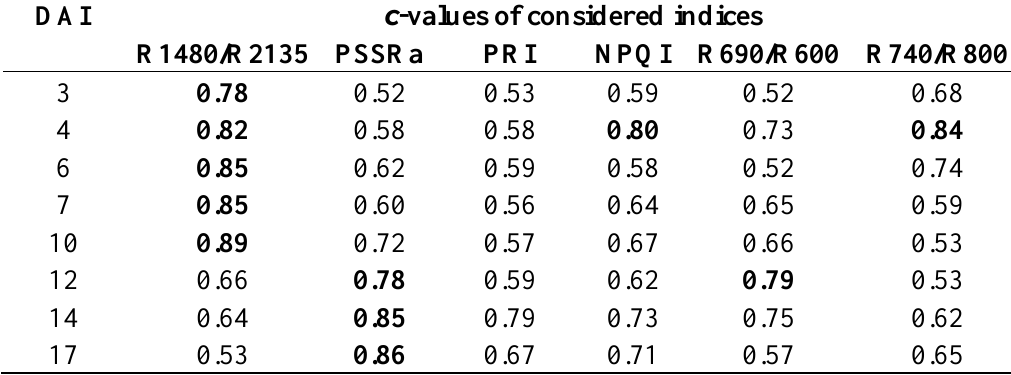
Table 2. Discriminatory performances of the indices considered in this research to discriminate between scab-inoculated and control leaves (c-values above 0.8 are considered to be